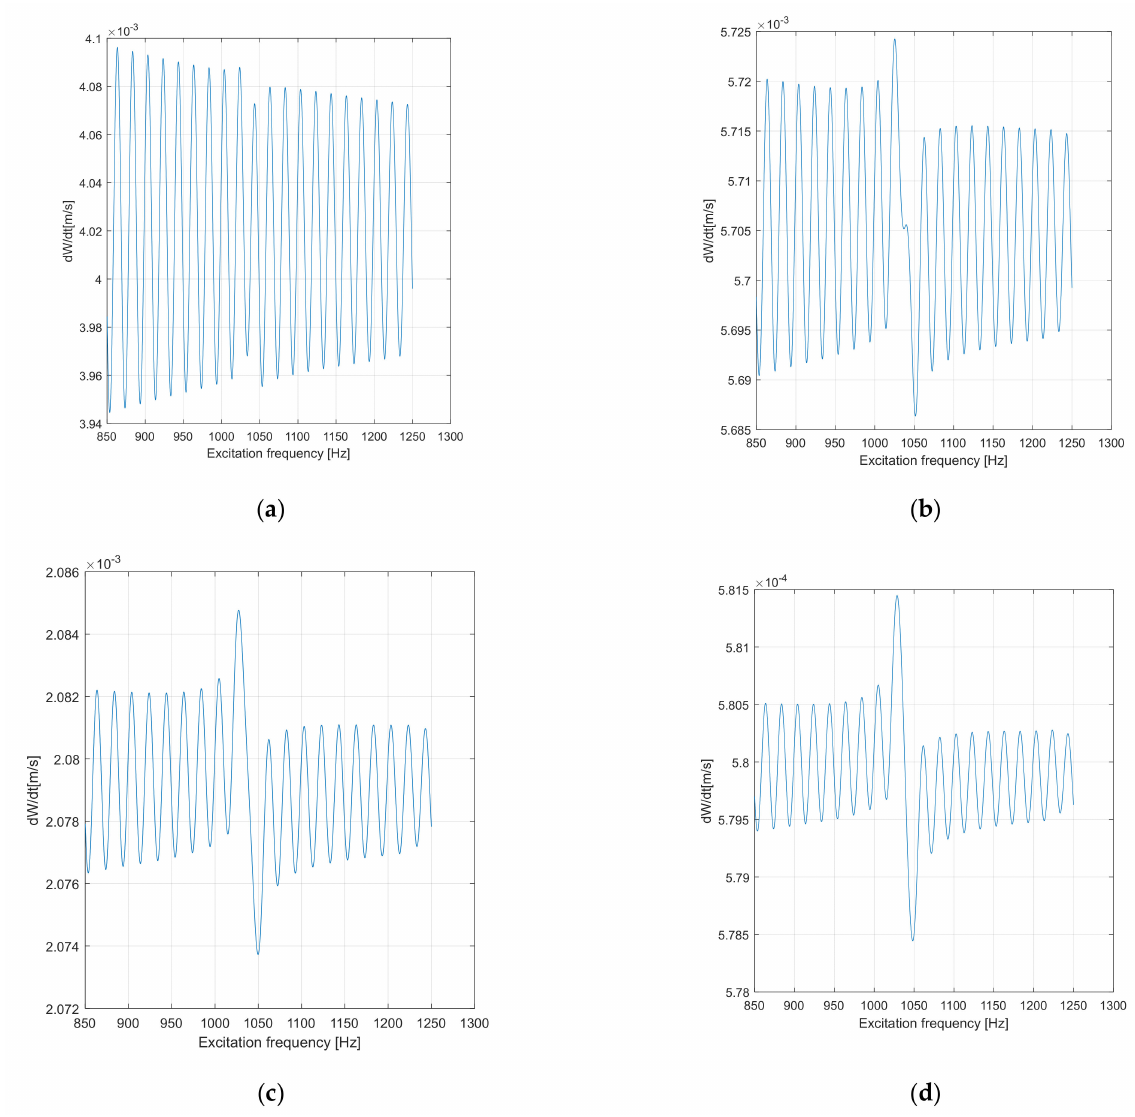
Figure 22. Nonstationary parametric velocity amplitude spectrum dW where µ = 0.623 × 10 − 4 . ( a ) ζ = 0.0016. ( b ) ζ = 0.0116. ( c ) ζ = 0.0216. ( d ) ζ = 0.0318. Here, m = 8 × 10 − 5